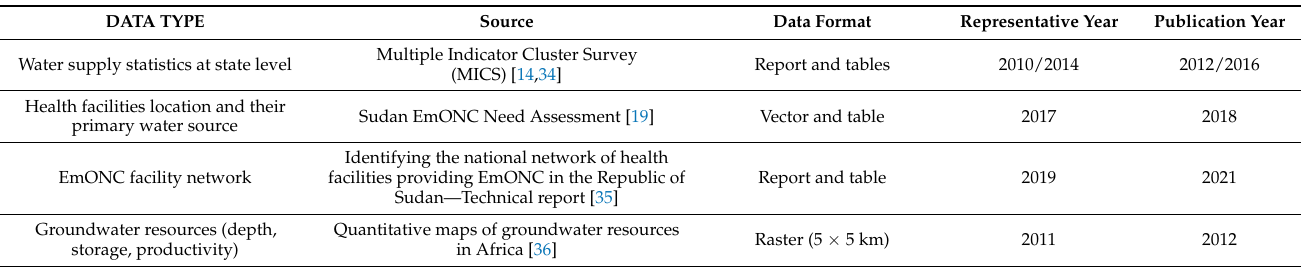
Table 2. Database of the DWSI input data, initial format, and year of